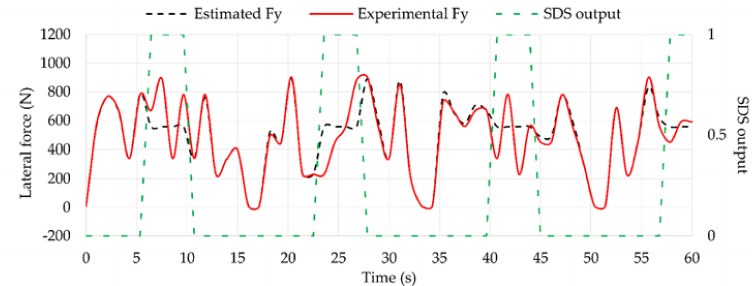
Figure 20. Simulation results of F y compared to experimental